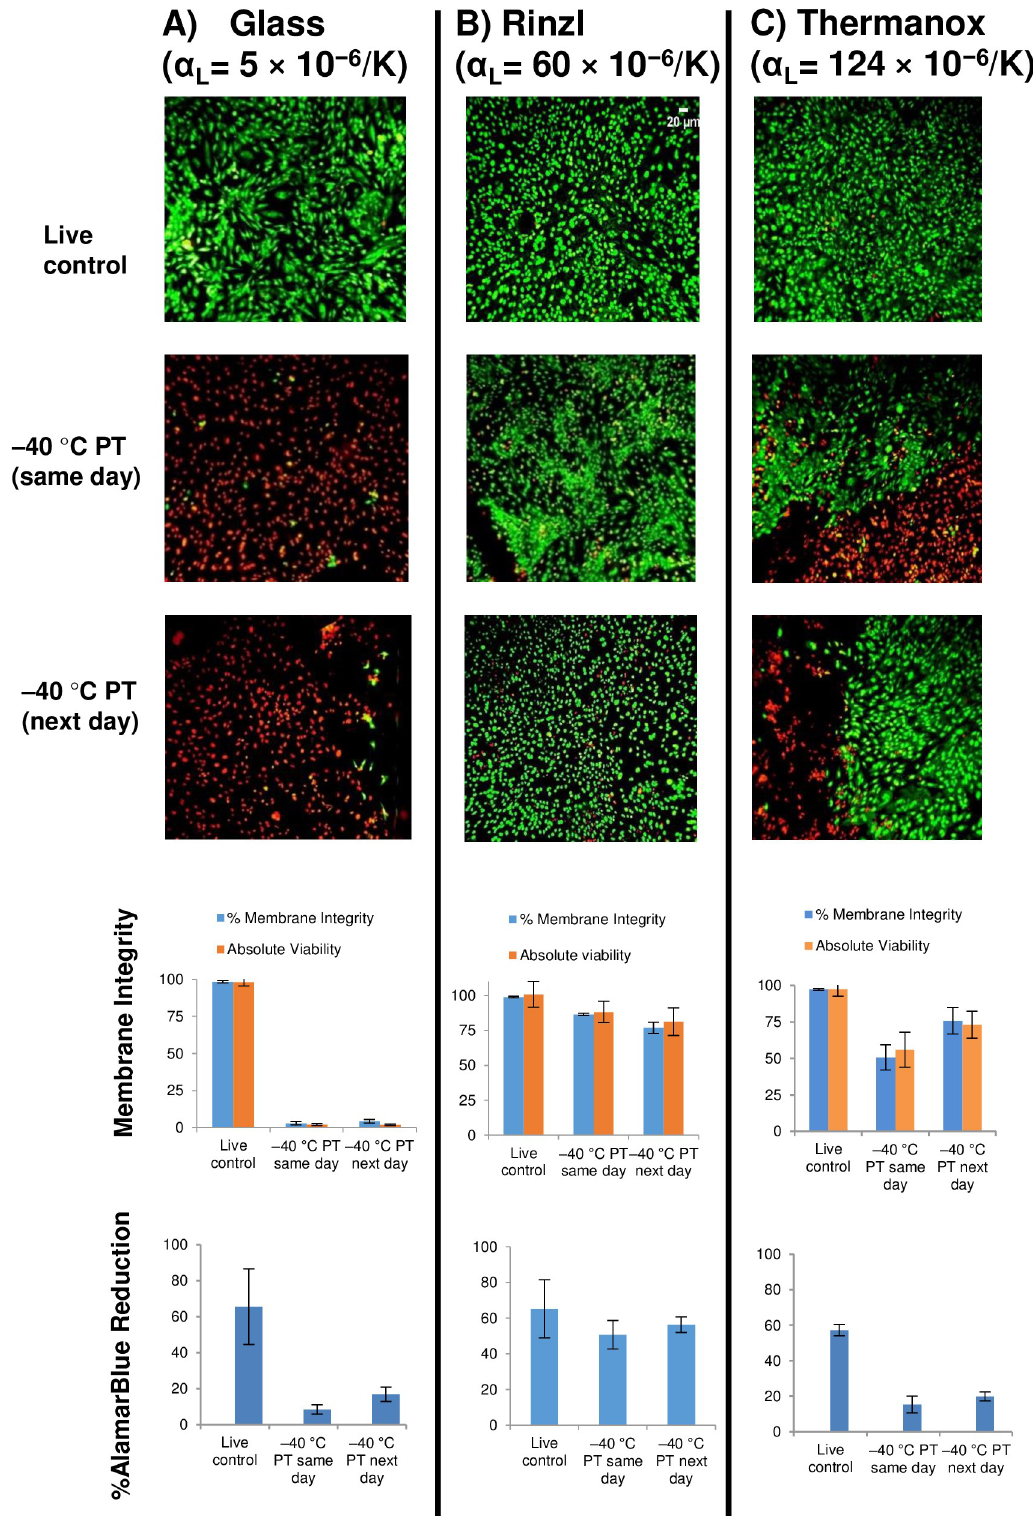
Fig 6. Cryopreservation of hCMEC/D3 monolayers on (A) glass, (B) Rinzl, and (C) Thermanox coverslips. Live control samples were unfrozen and the frozen samples (labelled –40˚C PT) were cooled at 1˚C/min to –40˚C in the presence of 5% DMSO,